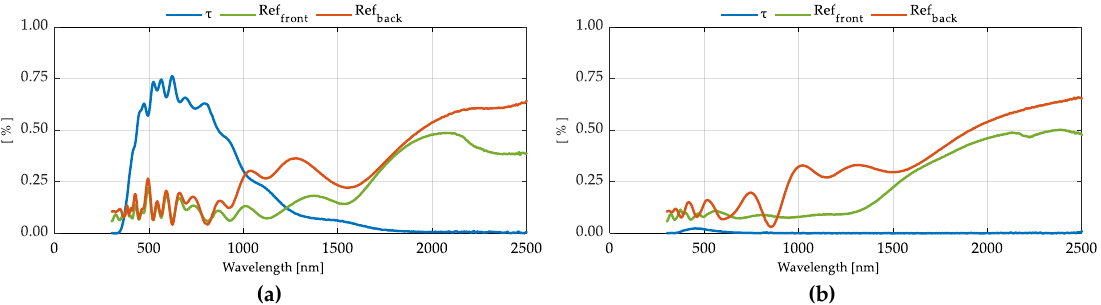
Figure 4. Spectral data of the electrochromic glass in its ( a ) clear and ( b ) tinted state.